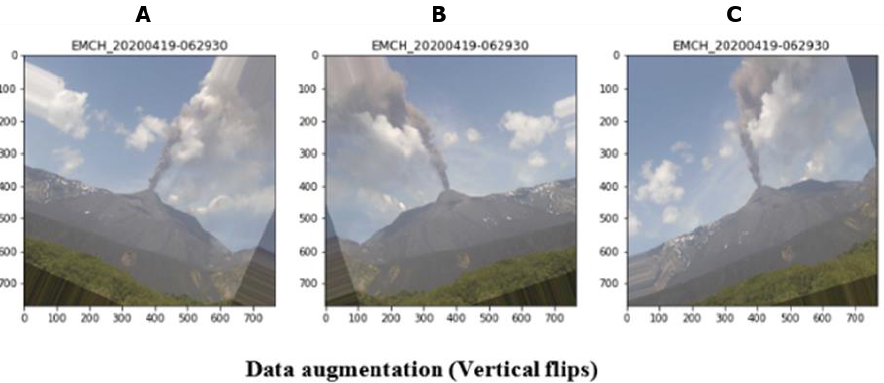
Figure 5. Example of data augmentation with vertical and horizontal flips (( A ) is a vertical right flipped image of 60 inclination degrees, ( B ) is a horizontal and vertical flipped and ( C ) is a horizontal and vertical flipped with distortion).